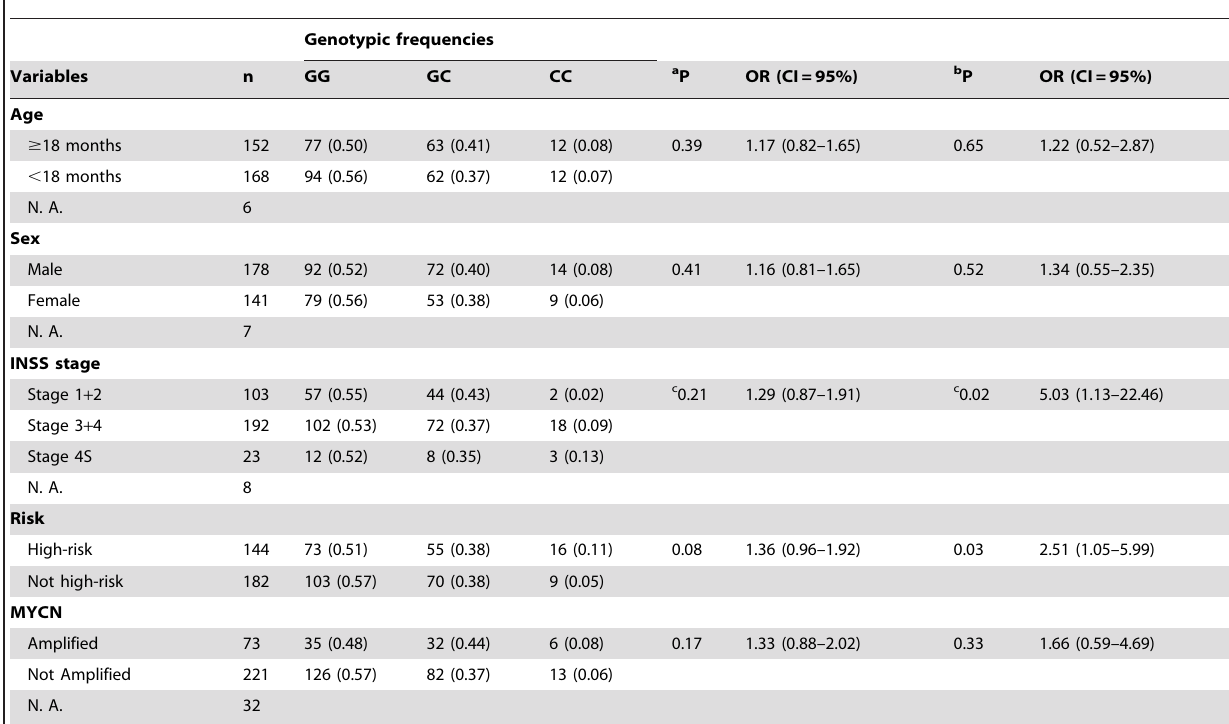
Table 2. Characteristics of NB patients stratified per IL-6 -176 (G . C) SNP